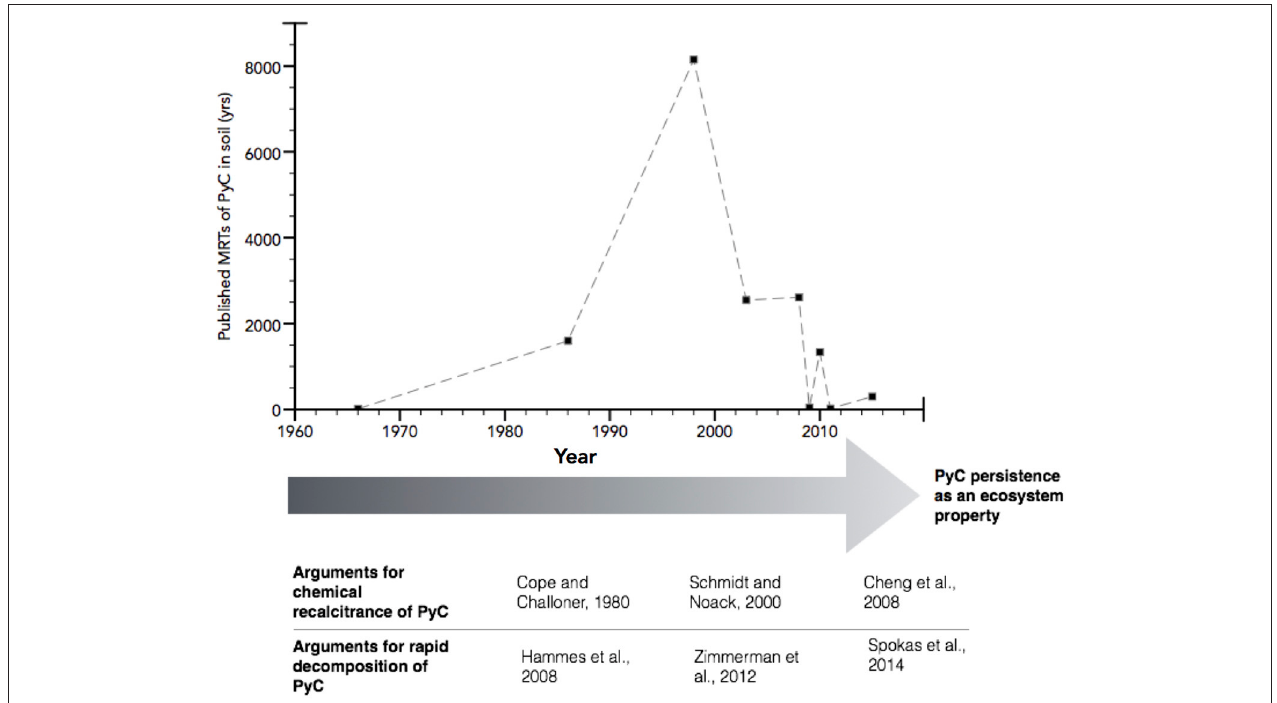
FIGURE 2 | This timeline of estimated MRTs of PyC and key papers illustrates the changing paradigm on controls of PyC persistence in the soil system. The estimate for char age from Cope and Chaloner (1980) was not included in the average of 300 million years, because it was not an estimate of turnover time, but it does reflect the view that PyC would reside in soil for very extended periods of time. Also, note that the x-axis is not